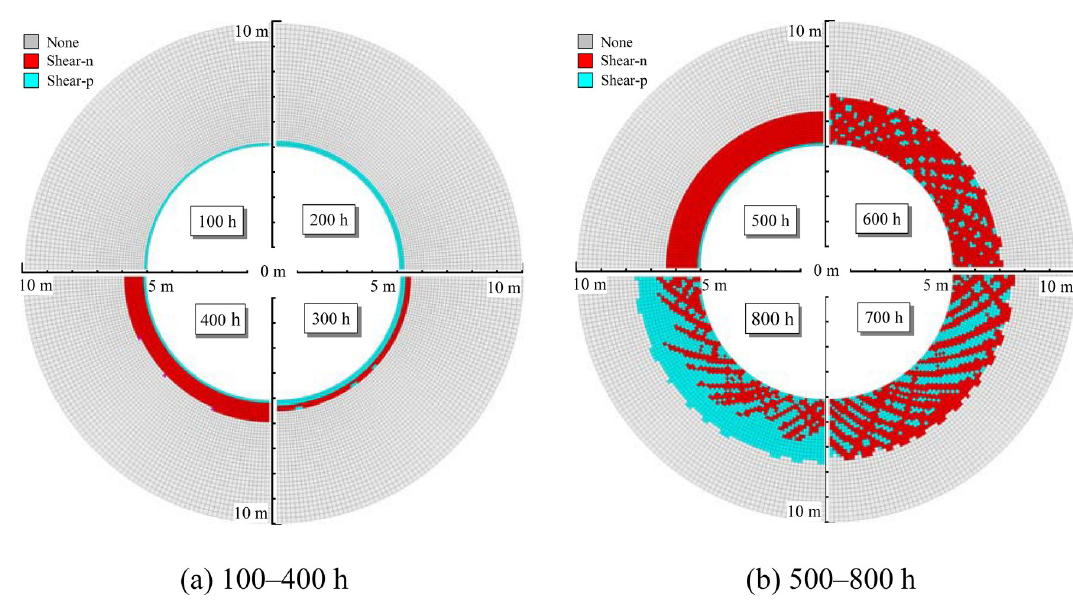
Fig 13. Evolution law of the plastic zone rock surrounding a tunnel (NBMC model). (a) 100–400 h (b) 500–800 h.